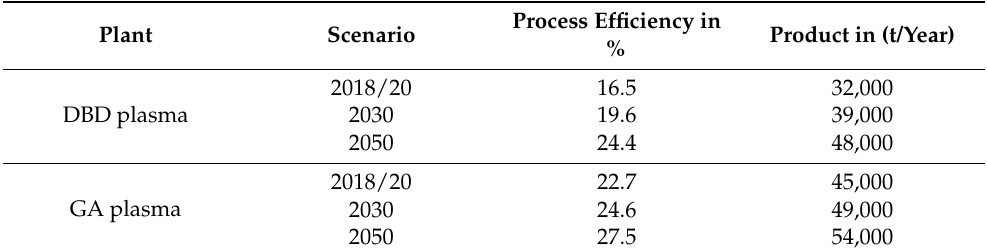
Table 7. Process efficiencies of the different scenarios for dielectric barrier discharge (DBD) and gliding Arc (GA)